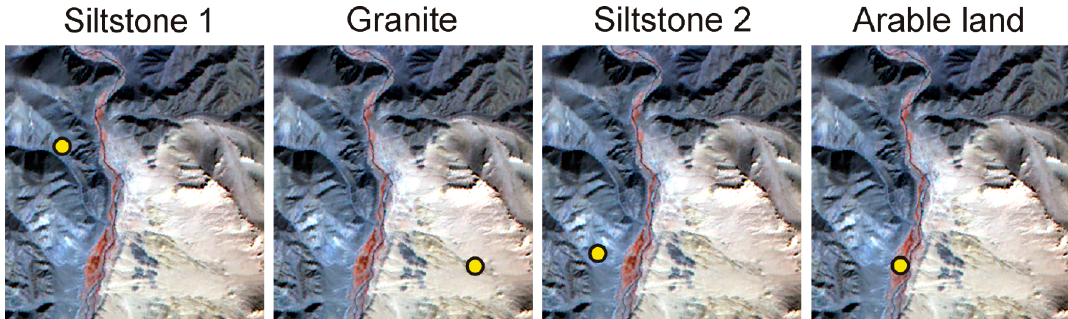
Figure 5. Four selected surface types that were used to assess the spectral quality between the original pixel reflectance spectra (ASTER and Landsat 8) and the corresponding spectra of the fused images employing the SAM and spectral feature fitting (SFF) methods.